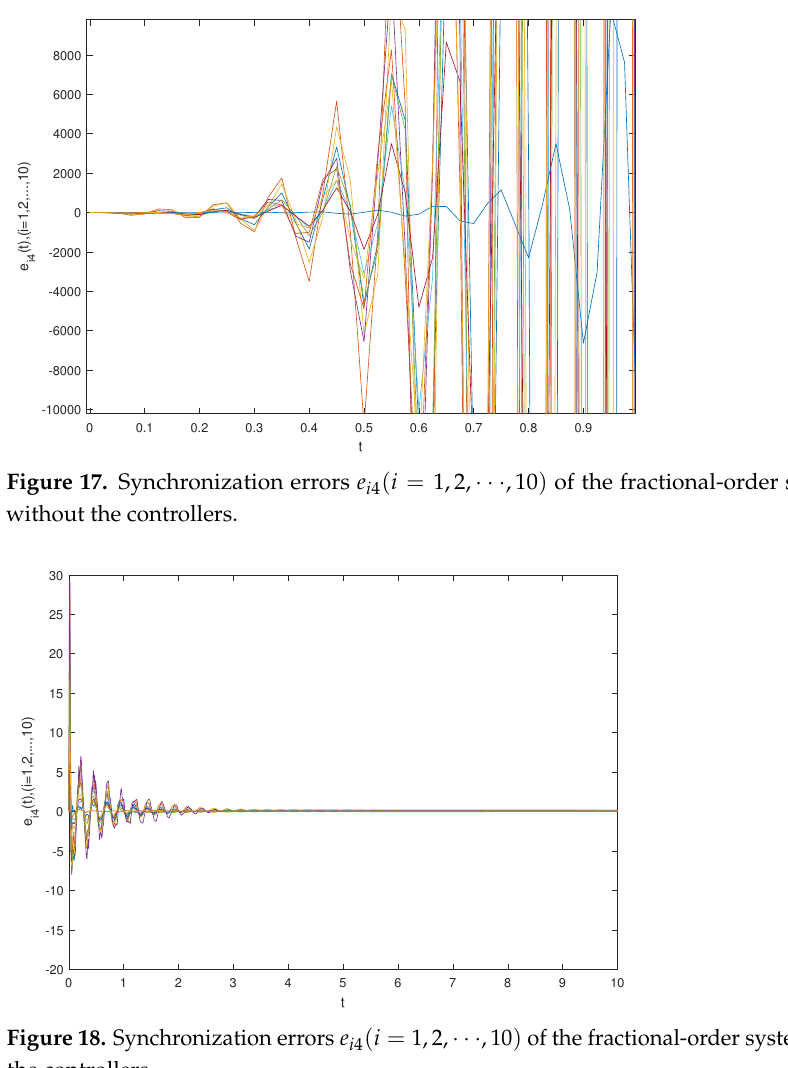
Figure 16. Synchronization errors e i 3 ( i = 1,2, · · · ,10 ) of the fractional-order system (34) and (35) with the controllers.